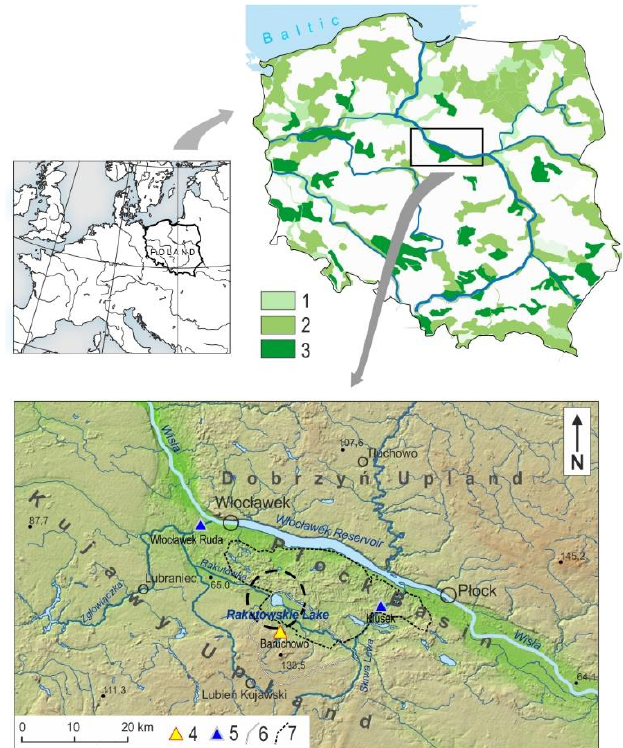
Figure 1. Study area location, 1. International ecological corridors, 2. International core area, 3. National core areas, 4. Rain gauging station, 5. Stream gauge, 6. Lake catchment area, 7. Gostynin–Włocławek Landscape Park border.